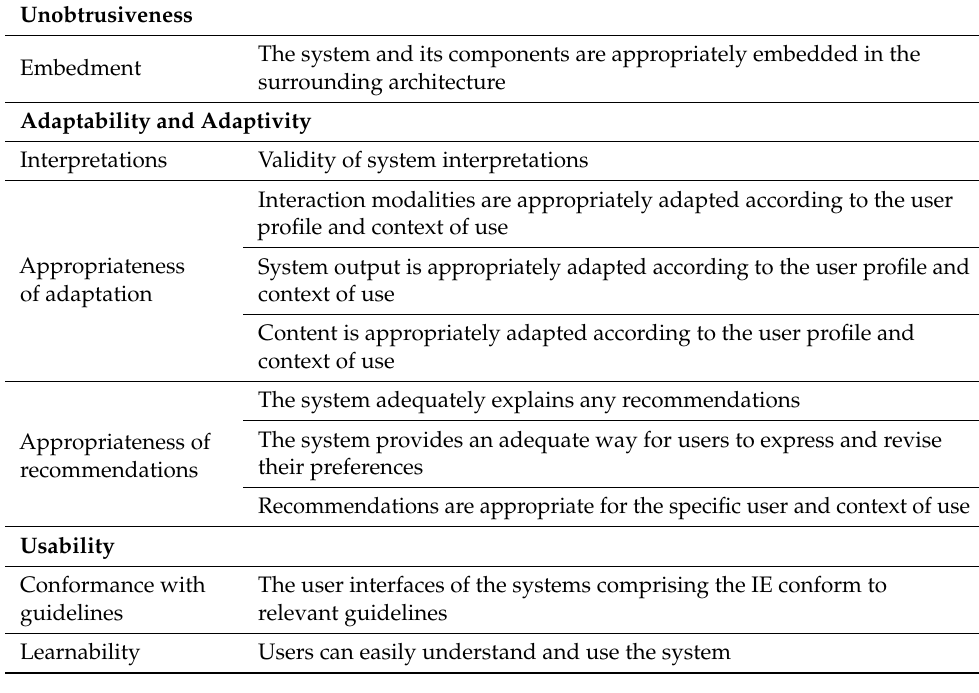
Table A1. UXIE metrics to be assessed through expert-based